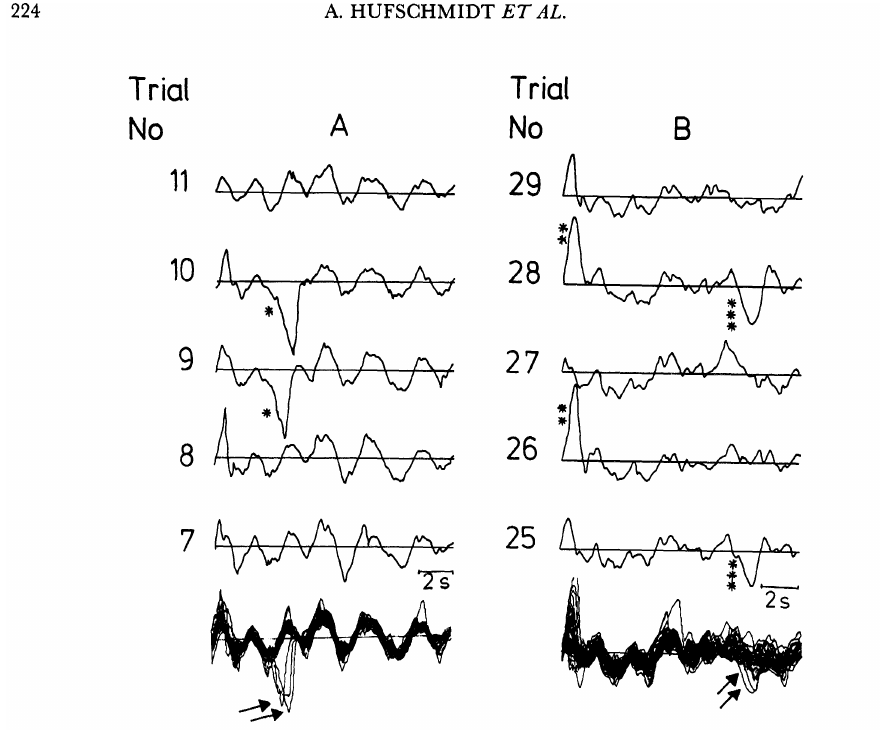
FIG. 4. Demonstration of single error curves with repetitive large errors in successive (A) or closely adjacent trials (B). The error marked * in trials 9 and 10 (A) is repeated only once (in trial 24) in the 32 successive trials superimposed on the bottom trace. In (B), error ** is repeated with one, error *** with two trials of normal shape in between. The error curves in (B) are taken from the same experiment shown in Fig. 3A, error ** being identical with the error marked by an arrow in Fig.